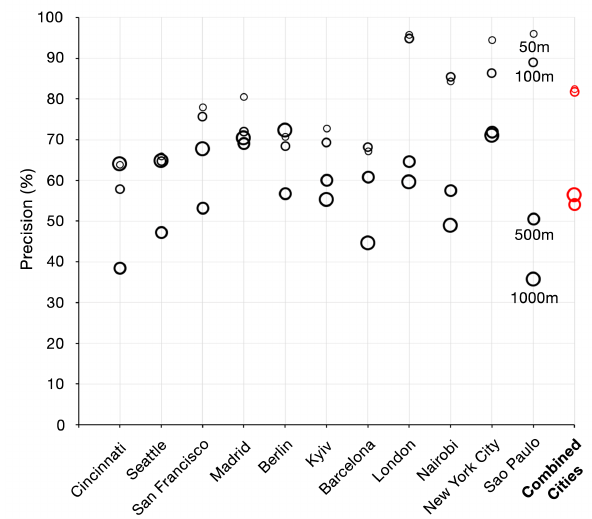
Figure 10. The performance of the k-nearest neighbours classifier (k = 30) for different tile sizes, different cities and a combined dataset. For each city, the model was trained using a 5-fold cross- validation approach using all cities but the selected city and validated against the latter. For the combined dataset, the model was trained using a 5-fold cross-validation approach and with precision calculated for the whole